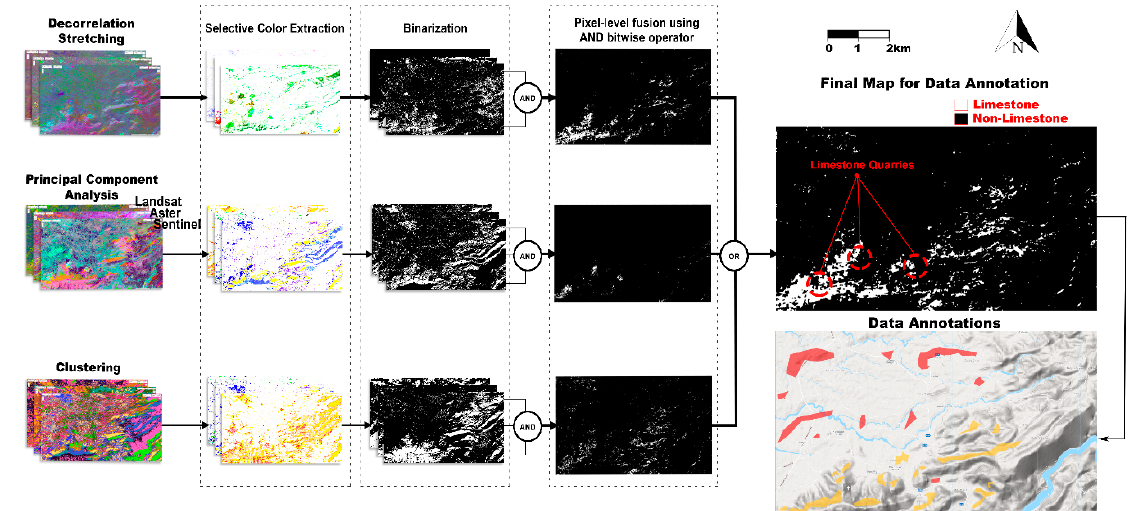
Figure 6. Method of image fusion uses selective color extraction and bitwise operation to extract common limestone indication from multiple data sources and multiple techniques to obtain reliable data annotation. The final map is also shown with the data annotations where yellow and red color geometric shapes represent limestone and landover pixels.